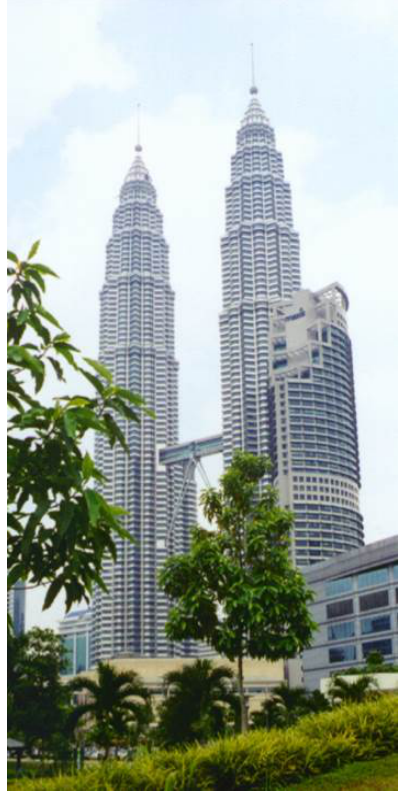
Figure 1. Shanghai Financial Center (left), Jin Mao Building (center), and Shanghai Tower (right) under construction (photo by Kyoung Sun Moon).